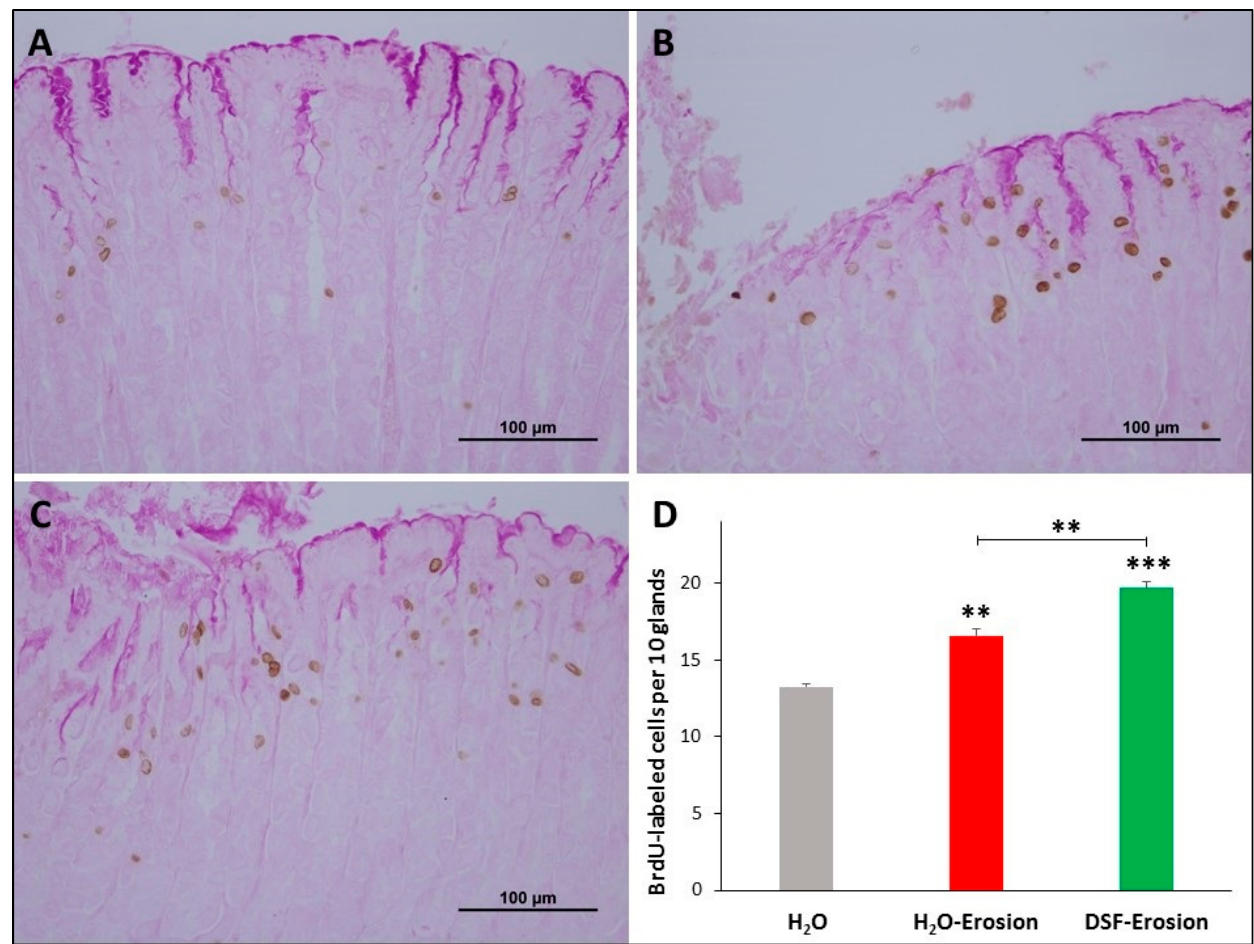
Figure 4. BrdU labeling in the gastric mucosae of H 2 O control ( A ), erosion-induced ( B ) and DSF-pretreated then erosion- induced ( C ) mice. The tissues were counter-stained with PAS to show mucus-secreting pit cells at the luminal surface. ( D ) Counts of the BrdU-labeled cells in control, erosion-induced and DSF-pretreated then erosion-induced mice ( n = 3 per group) are presented as mean ± SE. In this figure and all following figures, asterisks above columns indicate significant difference when the value of that column is compared with the H 2 O control. Asterisks above the line indicate differences between adjacent groups ** p < 0.01, *** p < 0.001; scale bar = 100 µm.